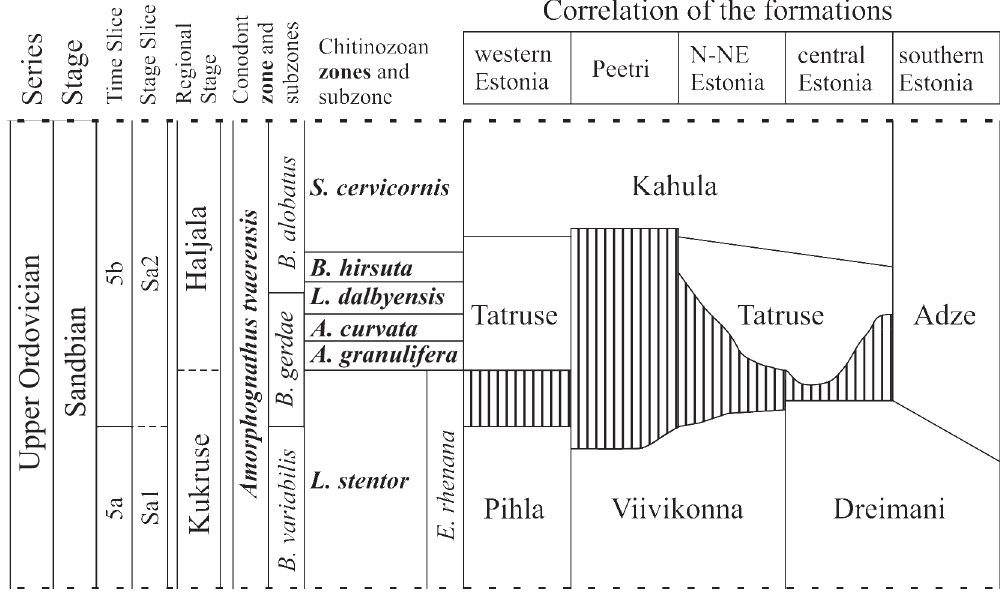
Fig. 7. Ordovician stratigraphy of Estonia in the Kukruse–Haljala boundary interval. Correlation of the formations is based on the Viki core section for western Estonia; Kerguta (Nõlvak & Bauert 2006), Taga–Roostoja, Vasknarva and Piilsi core sections for N– NE Estonia; Koigi, Tartu and Mehikoorma core sections for central Estonia; Valga and Ruhnu core sections for southern Estonia. Time Slices are according to Webby et al. (2004) and Stage Slices according to Bergström et al.